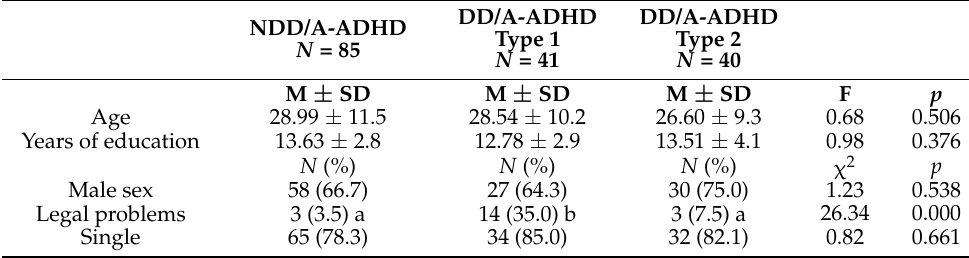
Table 1. Demographic and clinical differences in adult Attention Deficit/Hyperactivity Disorder (A-ADHD) patients with and without Dual Disorder